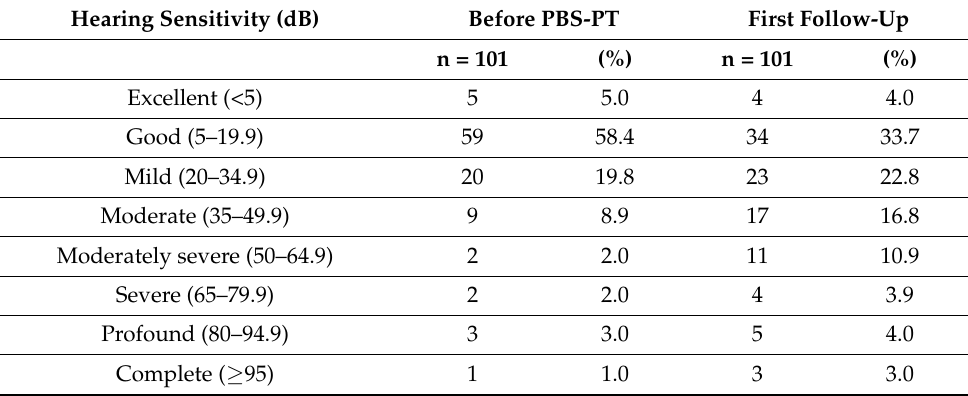
Table 2. Hearing sensitivity before and after PBS-PT in all 101 ears according to GBD * Expert Group on hearing loss